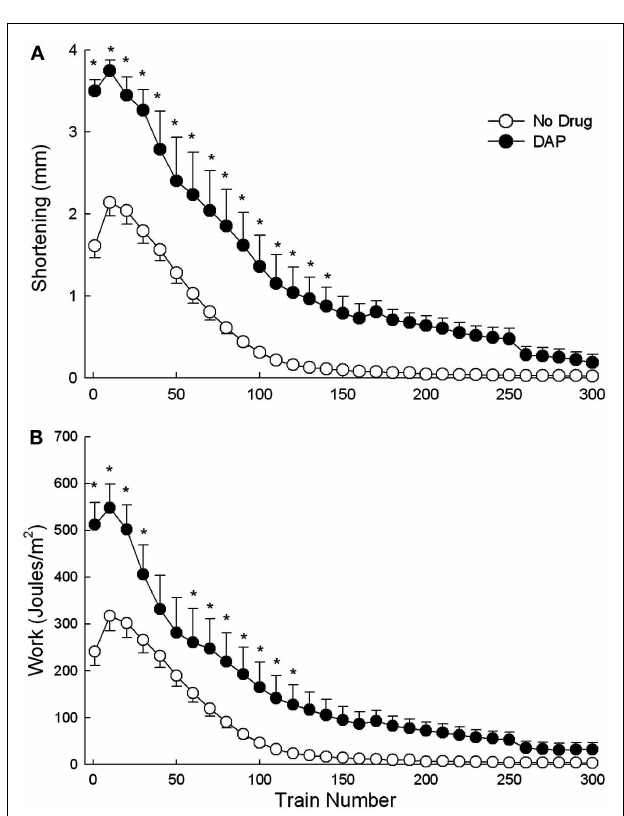
FIGURE 4 | Effects of DAP on maximum shortening (A) and work (B) during 40Hz isotonic contraction at 40% load over the first 60 trains. Values are means ±